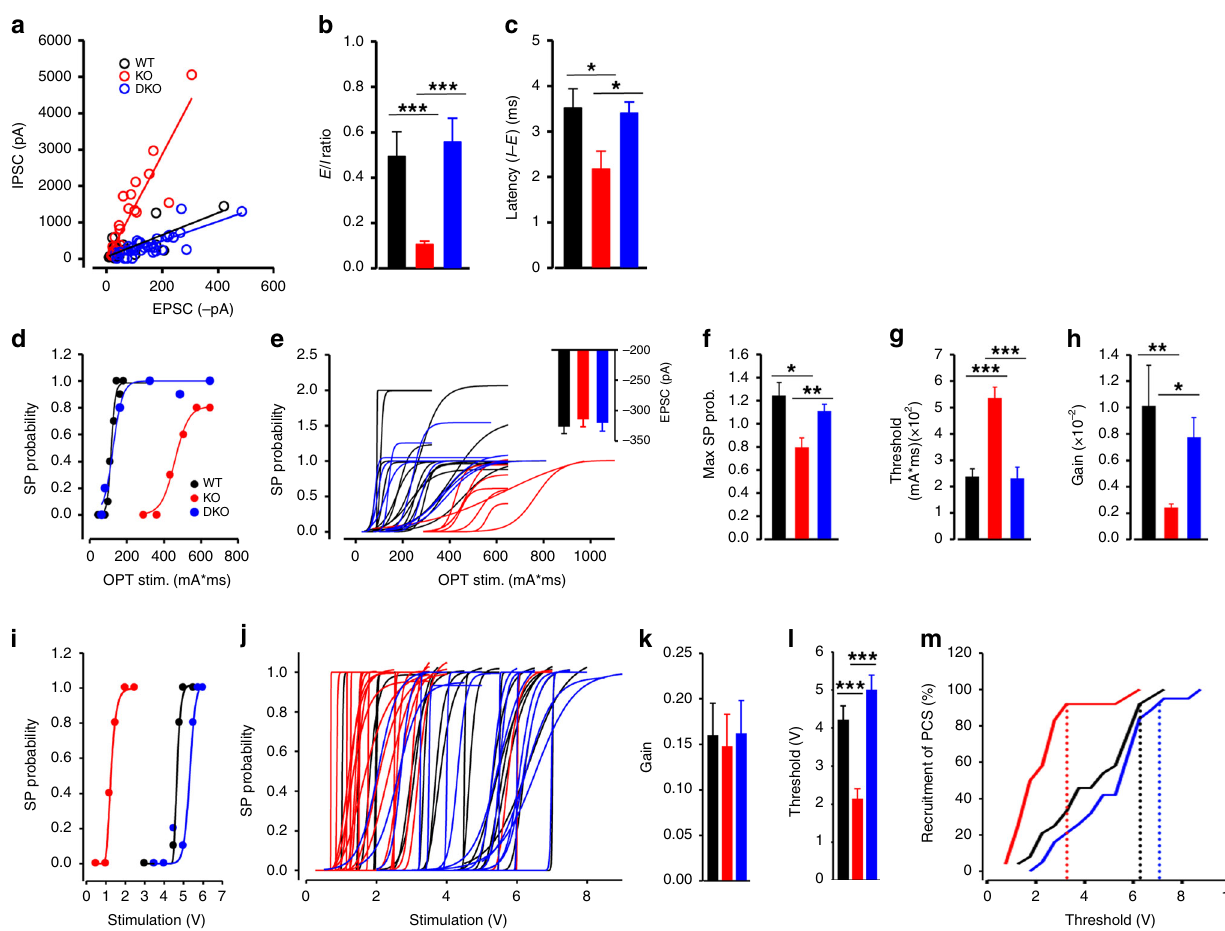
Fig. 8 The synaptic inputs, response threshold and dynamic range at the layer 2/3 dACC pyramidal neurons are normalized in PV-DKO mice. a – c MD thalamocortical projections to the dACC were photoactivated to elicit monosynaptic excitatory response at L2/3 pyramidal neurons and compare the di- synaptic feedforward inhibitory inputs. PV-DKO mice showed normalized a E-I relationship, b E/I ratio, and c the latency to the IPSC after EPSC. WT (black), PV- Lmo4 KO (KO, red), PV-DKO (blue, n = 35 cells/12 mice). d – h Spike probability (SP) shows restored response of L2/3 pyramidal neurons to MD thalamocortical stimulation in DKO mice ( n = 9 cells/5 mice). Inset ( e ), histogram shows similar EPSC amplitudes for each of the three genotypes. f Maximum spike probability. g Activation threshold. h Gain. i – m Response of L2/3 pyramidal neurons to layer 1 electrical stimulation is restored in DKO mice ( n = 19 cells/7 mice). Dashed lines show thresholds to recruit 92% of cells for each genotype in m . *, **, ***, p < 0.05, 0.01, 0.001,